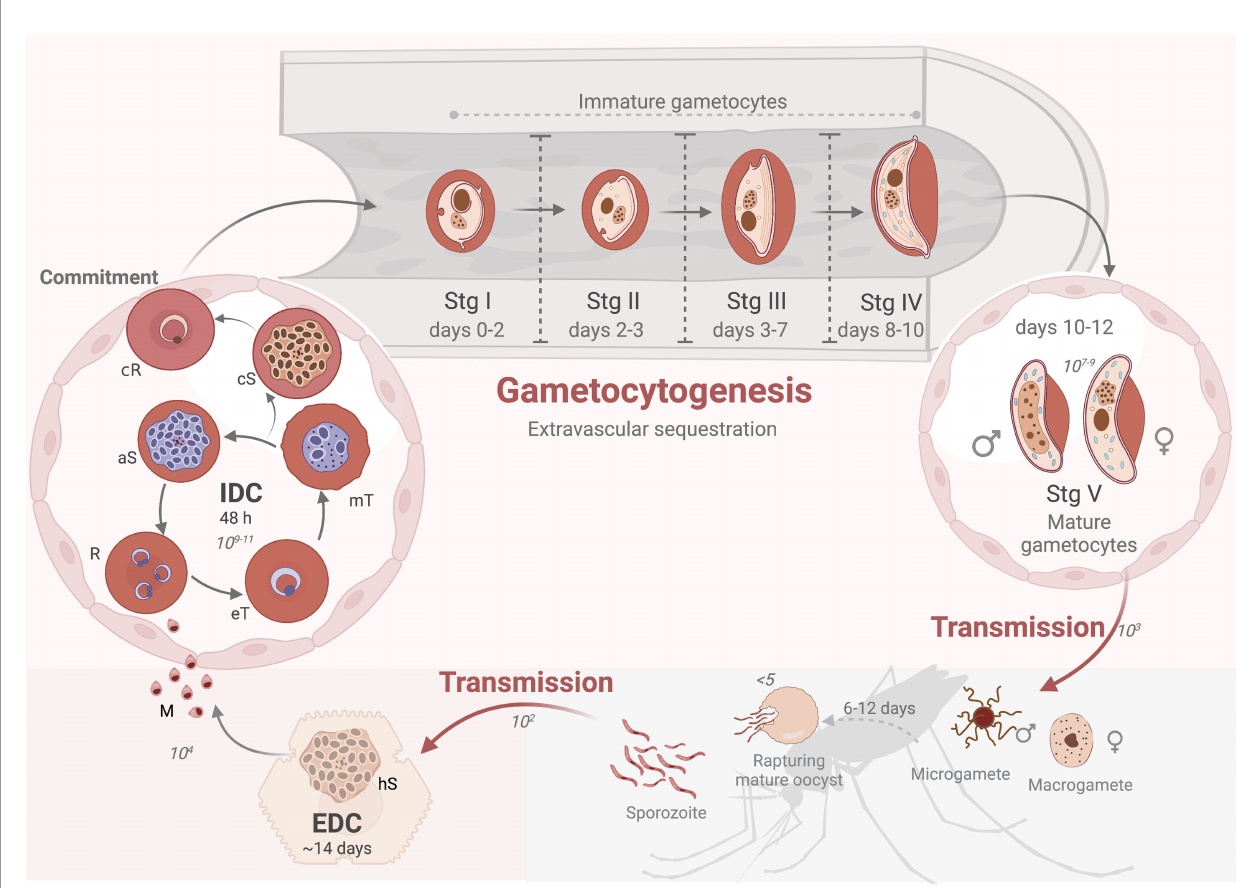
FIGURE 1 | The Plasmodium falciparum life cycle. The life cycle has three broad phases: sexual reproduction in the mosquito vector (grey shaded area), asexual reproduction in the liver (exo-erythrocytic developmental cycle, EDC, in dark pink) and asexual reproduction (intra-erythrocytic developmental cycle, IDC) and gametocyte differentiation in erythrocytes (light pink). Transmission to humans is initiated by ~10 2 sporozoites, which migrate to the liver through peripheral circulation to liver cells and replicate to form hepatic schizonts (hS). Hepatic asexually committed merozoites (M), released into the bloodstream, infect erythrocytes to initiate the IDC where parasites develop through ring (R), early trophozoite (eT), mature trophozoite (mT) and asexual schizont (aS) in 48 h, resulting in 10 11 parasites. Gametocyte-committed schizonts (cS) results in either male or female committed rings (cR) that mature in extravascular spaces (e.g., bone marrow). P. falciparum gametocytes have fi ve distinct morphological stages during development, stage I-IV as immature gametocytes taking ~10 days to form and ~10 7-9 mature male and female stage V gametocytes returning to the circulatory system (~days 10-12), to be transmitted (~10 3 gametocytes) to the mosquito. This is followed by gamete activation, fertilization, and production of an oocyst for sporogony. Created and modi fi ed with